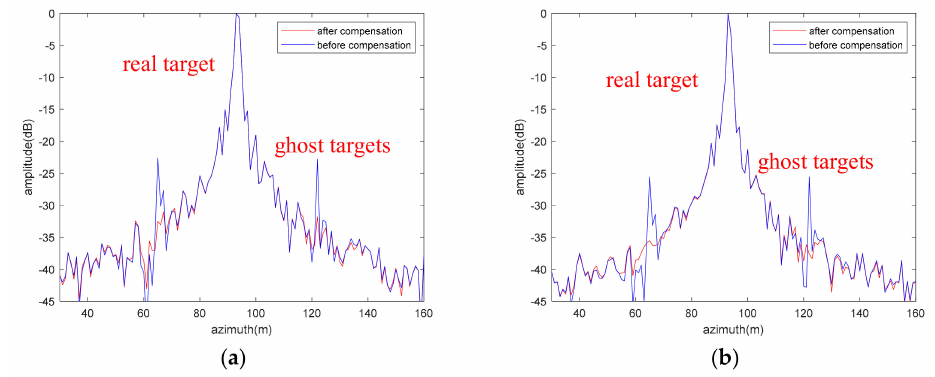
Figure 31. Azimuth profiles of T 1 ( a ) and T 2 ( b ) in Figure 30. It can be seen from Figure 31a,b that after the vibration phase compensation, the left ghost target of T 1 dropped from − 22.62 to − 32.42 dB and the right ghost target of T 1 dropped from − 22.79 to − 31.86 dB. The left ghost target of T 2 dropped from − 22.58